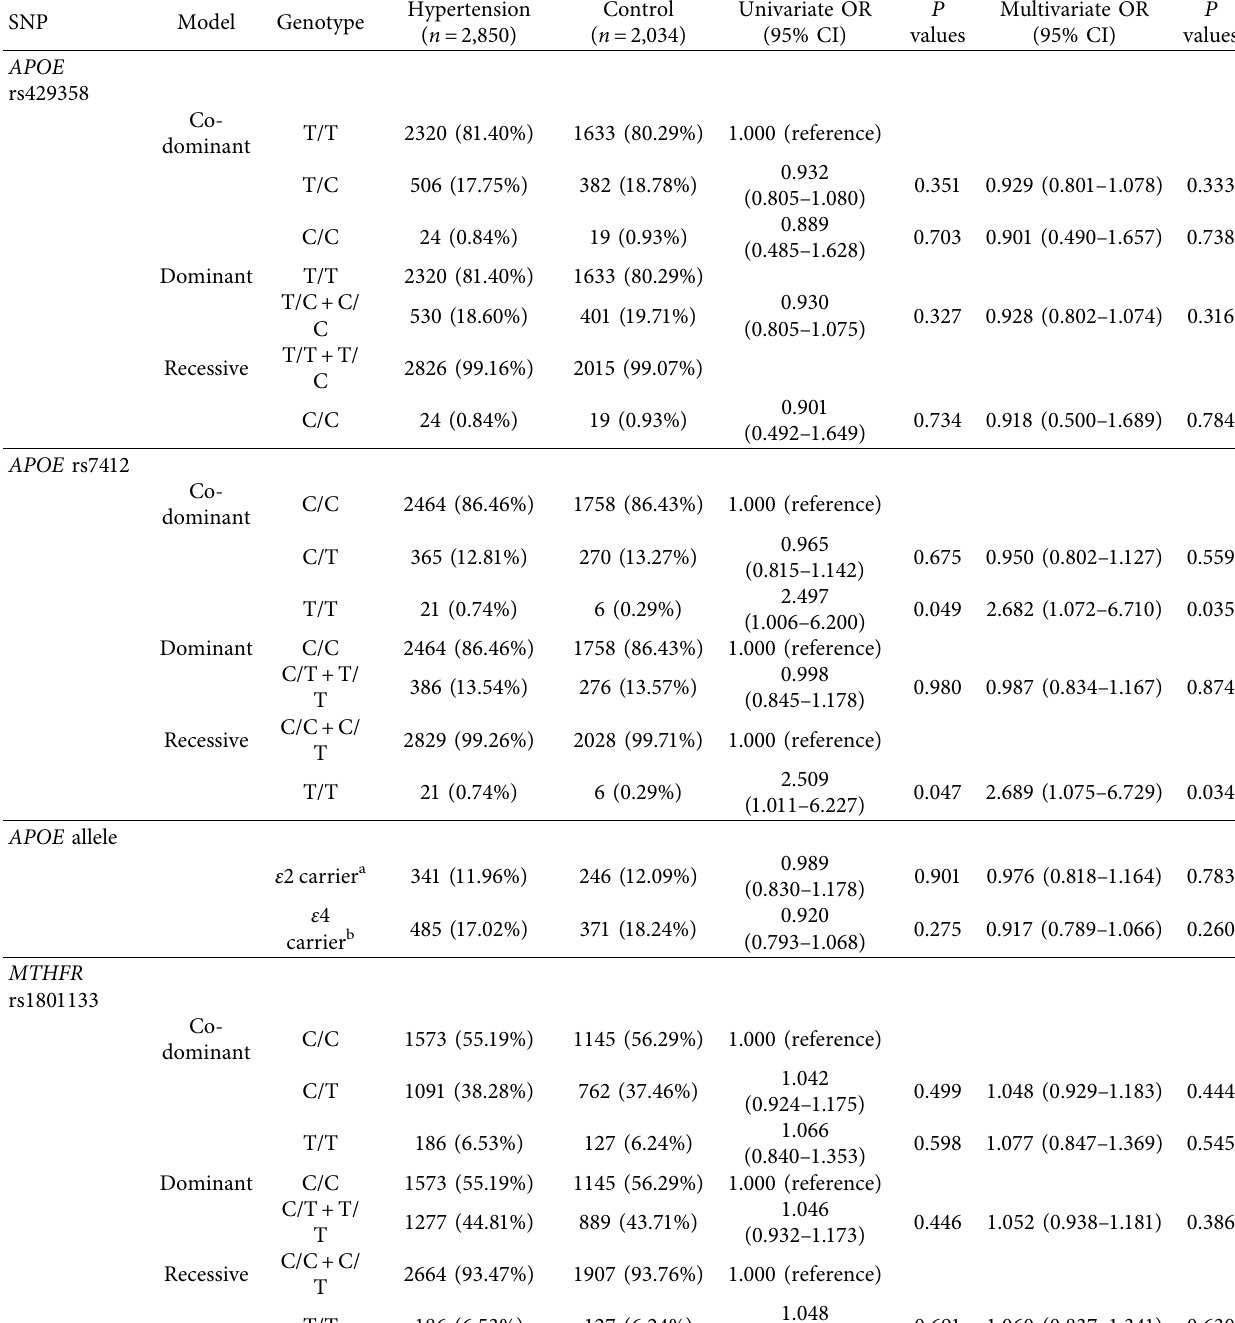
Table 5: Association of APOE rs429358, rs7412, and MTHFR rs1801133 polymorphisms with